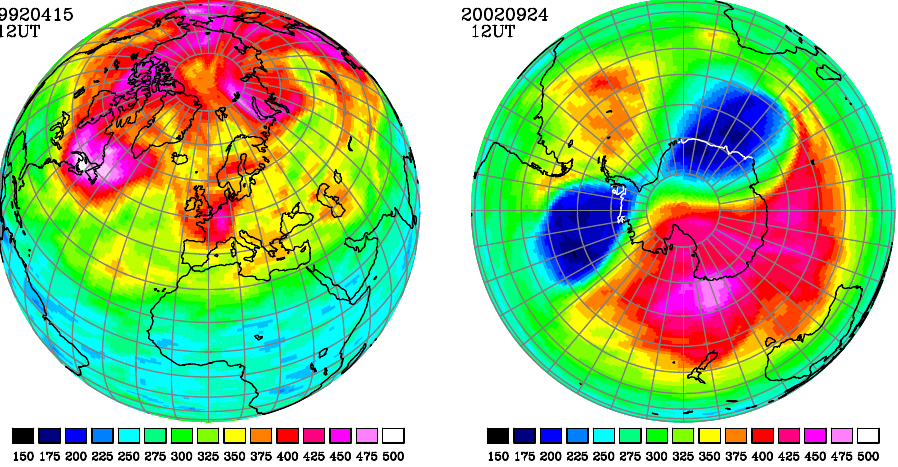
Fig. 3. Examples of the analysed MSR ozone field in DU. The left panel shows a low pressure system over Western Europe on 15 April 1992. The right panel shows the split ozone hole over Antarctica on 24 September 2002.